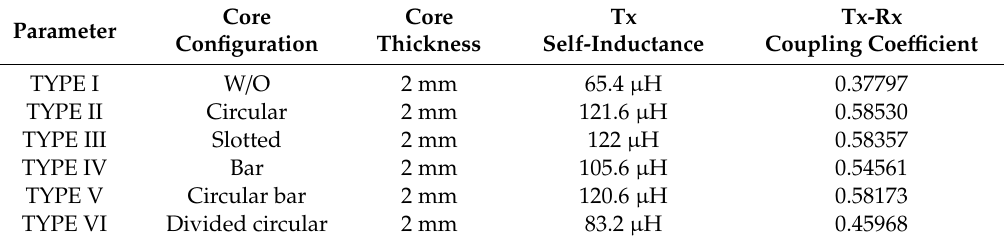
Figure 7. Optimized magnetic coupler shape: ( a ) ferromagnetic core of the T X pad, and ( b ) overall magnetic coupler shape including the R X and T X pad. Table 4. Design results of the pad according to the ferromagnetic core